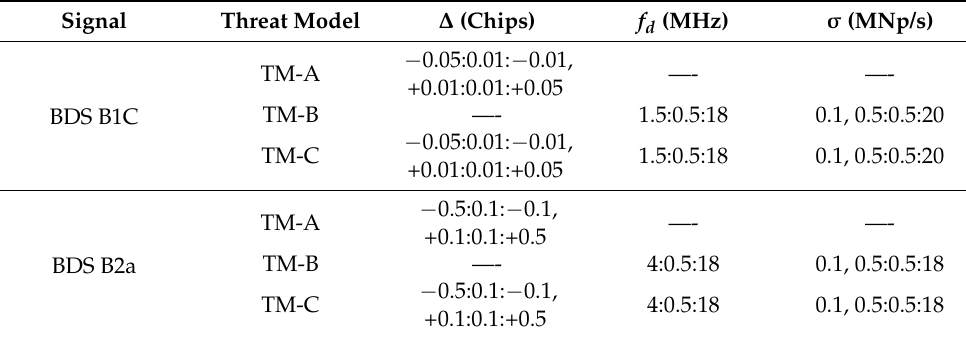
Table 3. Discretization of the threat spaces of BDS B1C and B2a signals. Signal